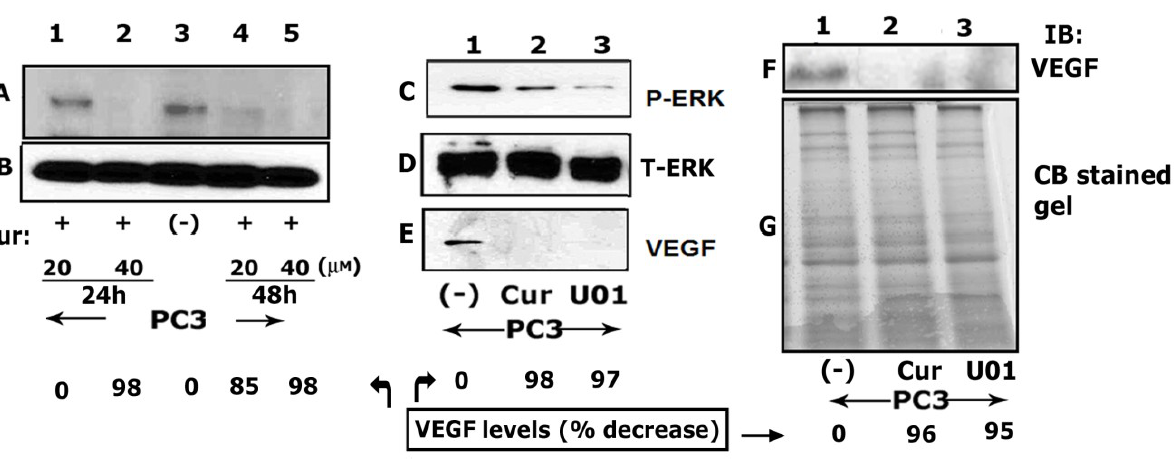
Figure 3. Curcumin reduces ERK phosphorylation and VEGF expression in PC3 cells. ( A ) and ( B ) PC3 cells were treated with 20 and 40 µM curcumin for 24 (lanes 1 and 2) and 48h (lanes 4 and 5). Untreated PC3 cells were indicated as (-) in lane 3. ( C – E ) Equal amount of lysate protein (20µg protein) made from untreated (-) and curcumin (lane 2) or MEK inhibitor UO126 (lane 3) treated PC3 cells were immunoblotted with a phospho-specific antibody to ERK1/2 ( C ). Membrane was stripped successively and reprobed with a VEGF antibody ( E ) and a non-phosphorylated ERK1/2 antibody ( D ) to demonstrate equal protein loading. ( F ) and ( G ) To determine the secreted levels of VEGF in PC3 cells treated with curcumin (lane 2) and MEK inhibitor UO126 (lane 3), equal amount of conditioned